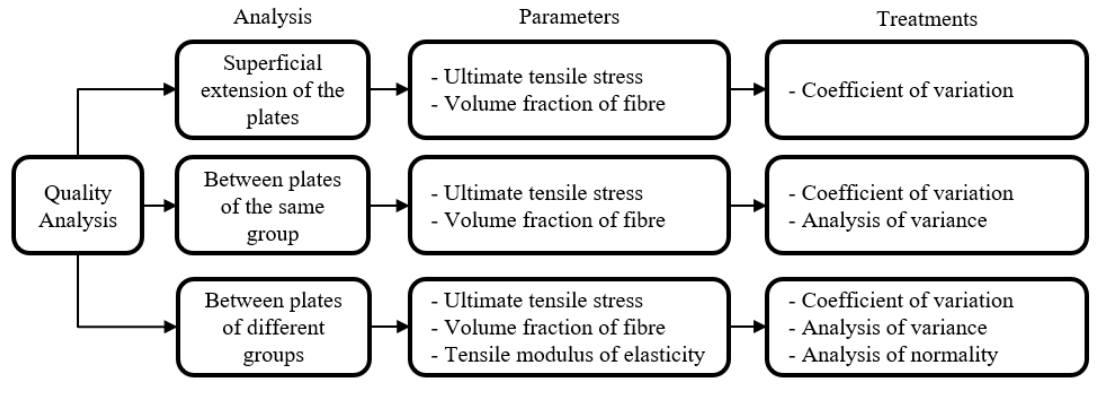
Figure 4. Evaluated parameters, with the respective statistical treatments, in each of the three analyzes level considered.